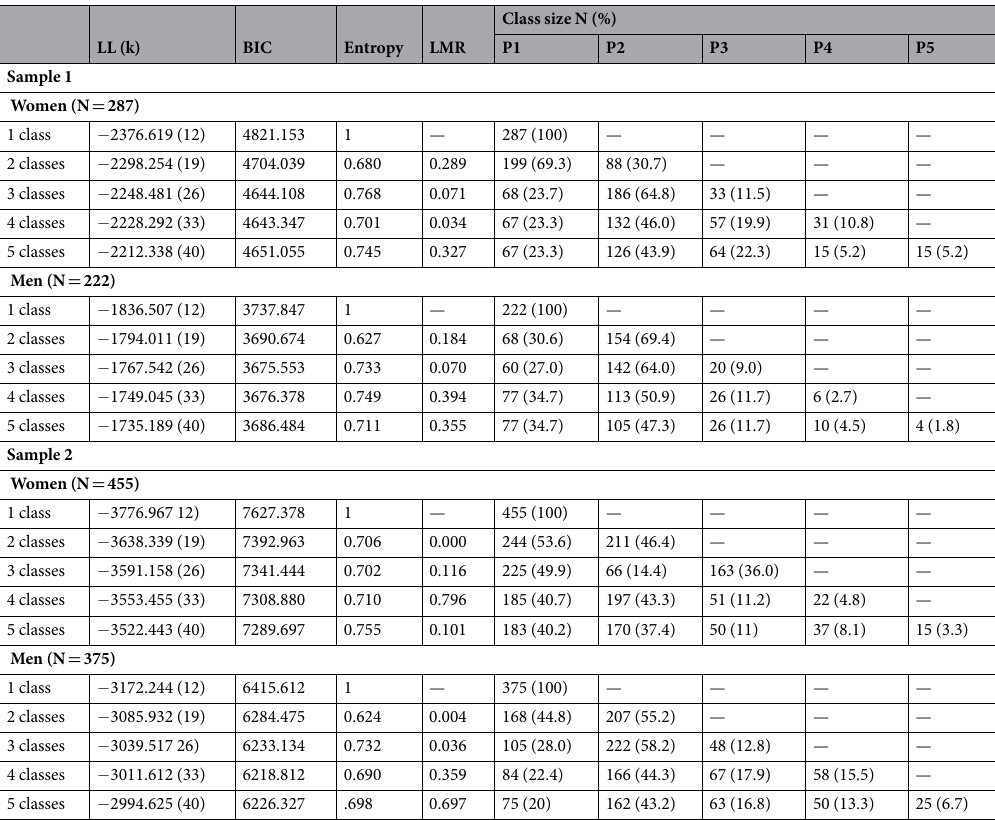
Table 1. Fit indices for the selected LPA models in Sample 1 and Sample 2. Statistical indices of the estimated LPA models. LL = loglikelihood; k = number of parameters; BIC = Bayesian Information Criterion; LMR =